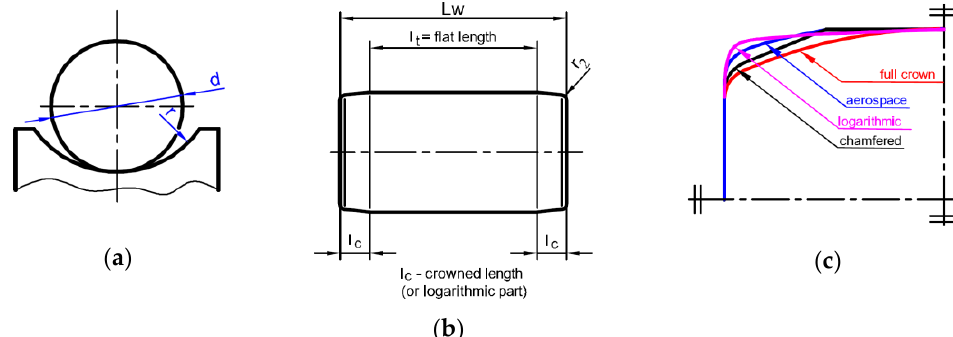
Figure 5. Geometry of rolling element: ( a ) ball and race conformity; ( b ) typical shape of cylindrical roller; ( c ) other shapes of cylindrical rollers.